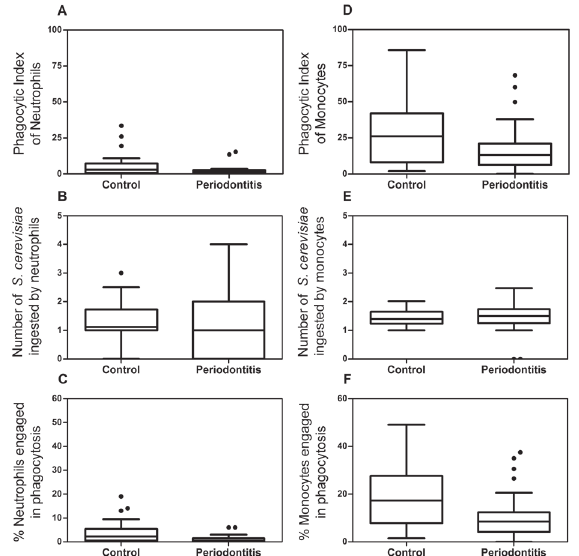
Figure 1- In vitro evaluation of the phagocytic capacity of neutrophils (left) or monocytes (right) in individuals with periodontal disease (P) and normal control individuals, using 2.5x10 5 non sensitized yeast per well. A: Reduction of the phagocytic index (p=0.01, Mann-Whitney